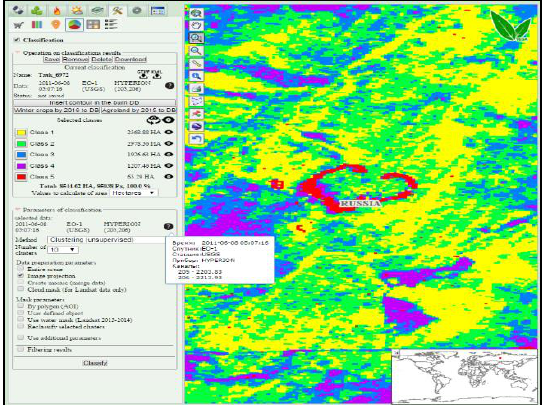
Figure 10. Determination of Open Flame class (5) in zone of forest fire. Hyperion observations (08.06.2011, Central part of East Siberia).